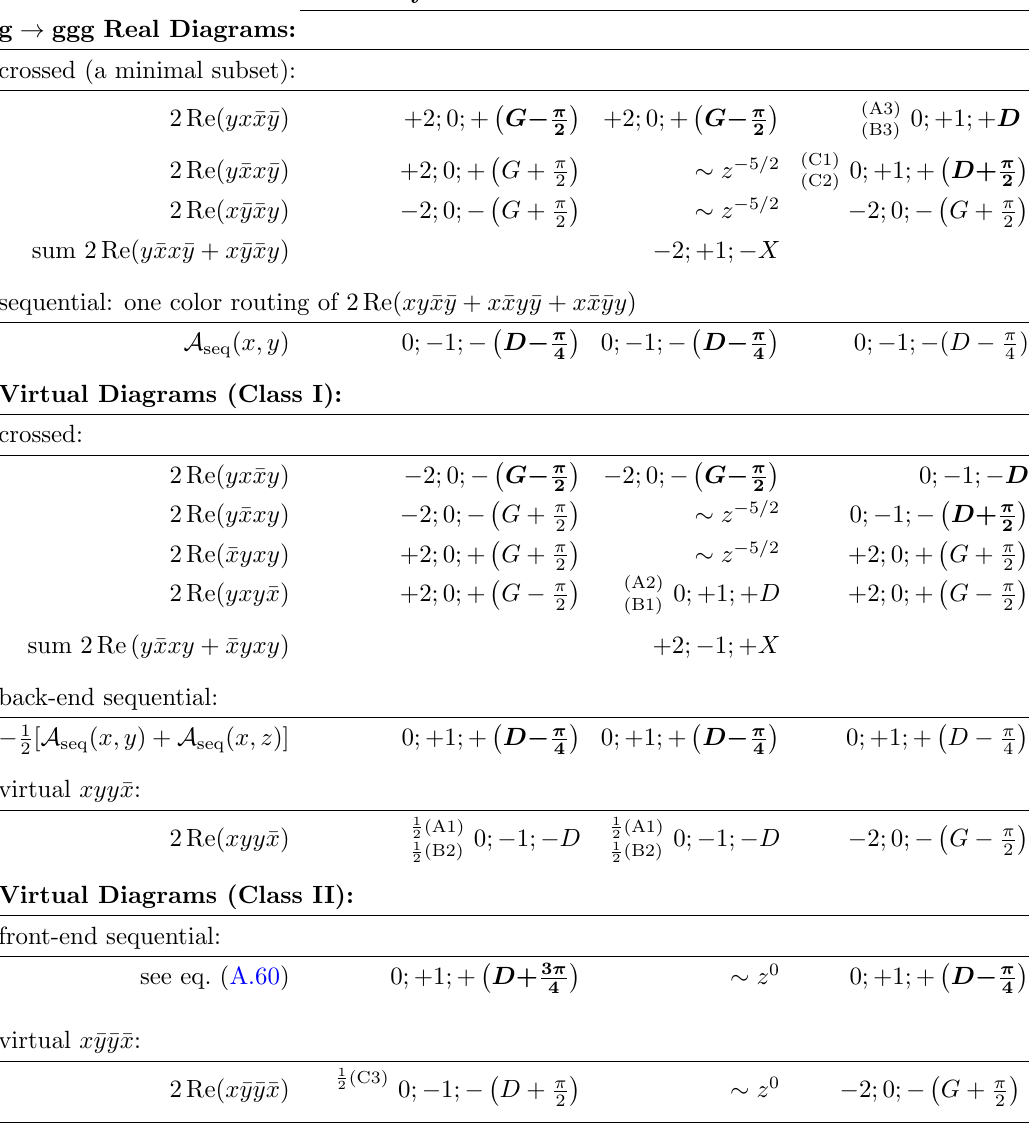
Table 1 . The limiting behaviors of di(cid:11)erent diagrams. Format explained in the